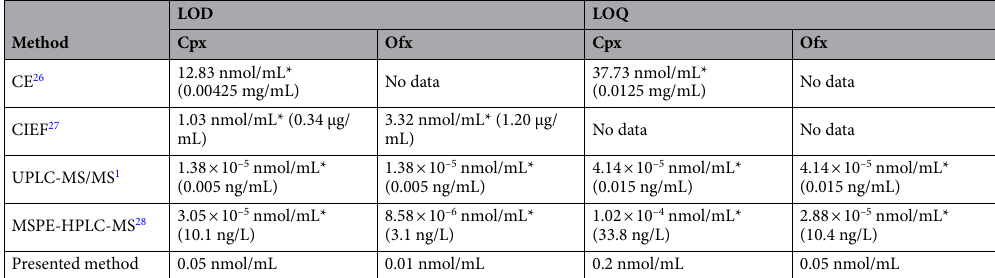
Table 2. Comparison the LOD and LOQ values of the described method with published methods. *LOD and LOQ values converted and reported in nmol/mL urine.